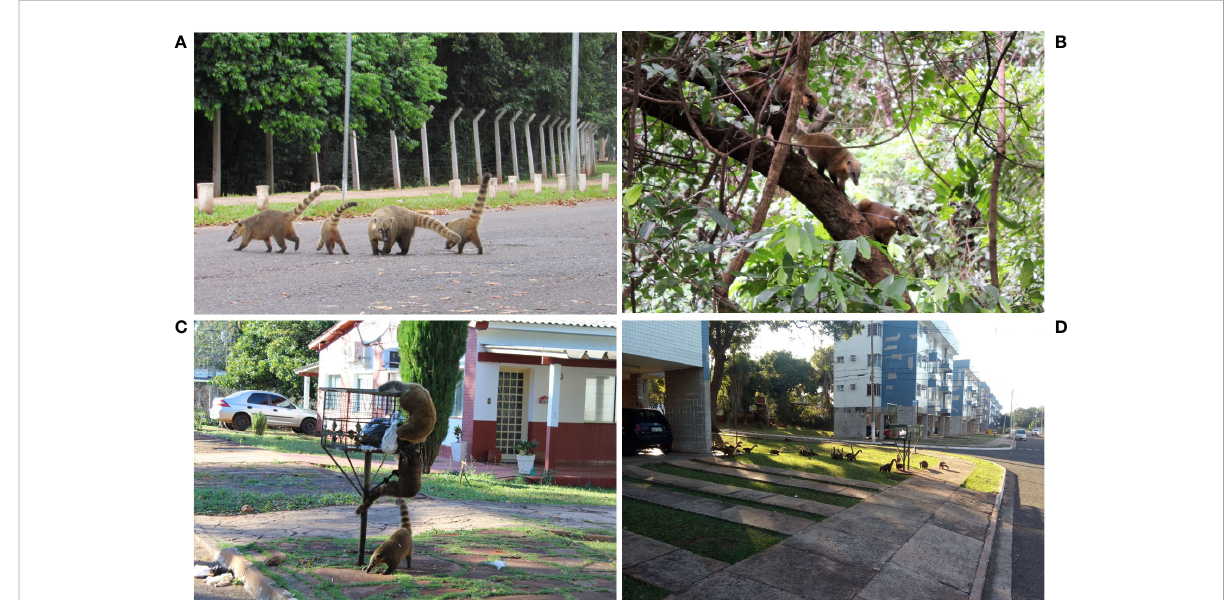
FIGURE 2 South American coatis ( Nasua nasua ) in the conservation unit “ Parque Estadual do Prosa ” (PEP) and in the residential area “ Vila da Base Ae ́ rea ” (VBA) at Campo Grande, Mato Grosso do Sul, Midwest Brazil. (A) South American coatis crossing paved streets from “ Parque dos Poderes ” to PEP; (B) South American coatis using the arboreal strata to move from PEP to Parque das Nac ̧ ões Ind ı ́ genas ; (C) South American coatis searching for food in outdoor trash cans in VBA; (D) South American coatis foraging near the not fenced houses in